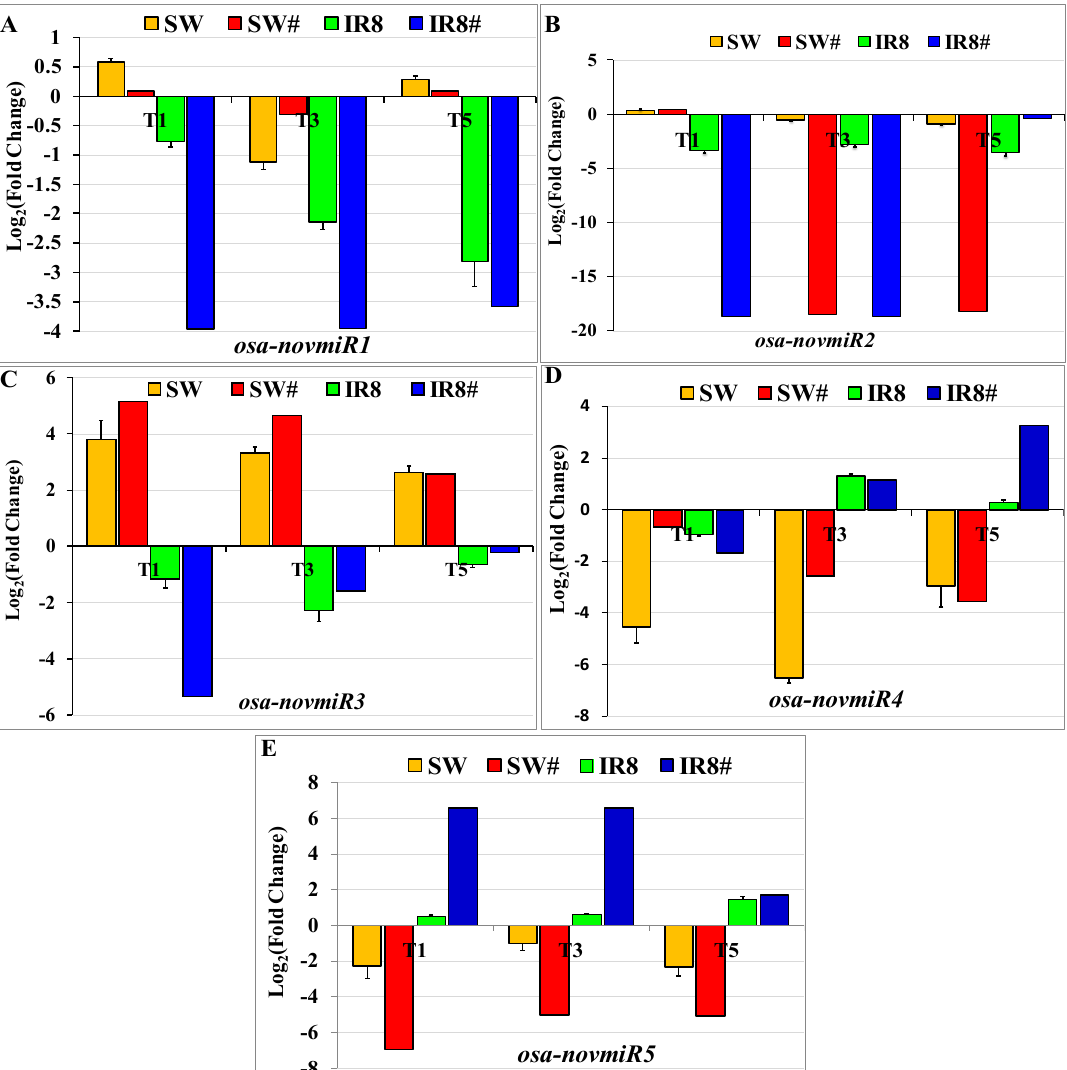
Figure 5. Validation of three differentially expressed known miRNAs, ( A ) osa - miR166c-3p , ( B ) osa - miR2102-3p , and ( C ) osa - miR530-3p through miRNA-specific qRT-PCR, identified from an miRNA sequencing results of Swarnaprabha and IR8 after low light treatment as compared to control. Each miRNA was amplified using mRQ 3′primer along with miRNA -specific and U6- specific 5′ primers . The primer sequences have been provided in Table S3. (# = m iRNA-seq). Error bars are ±SD of the average of three miRNA-specific q RT-PCR replicates.